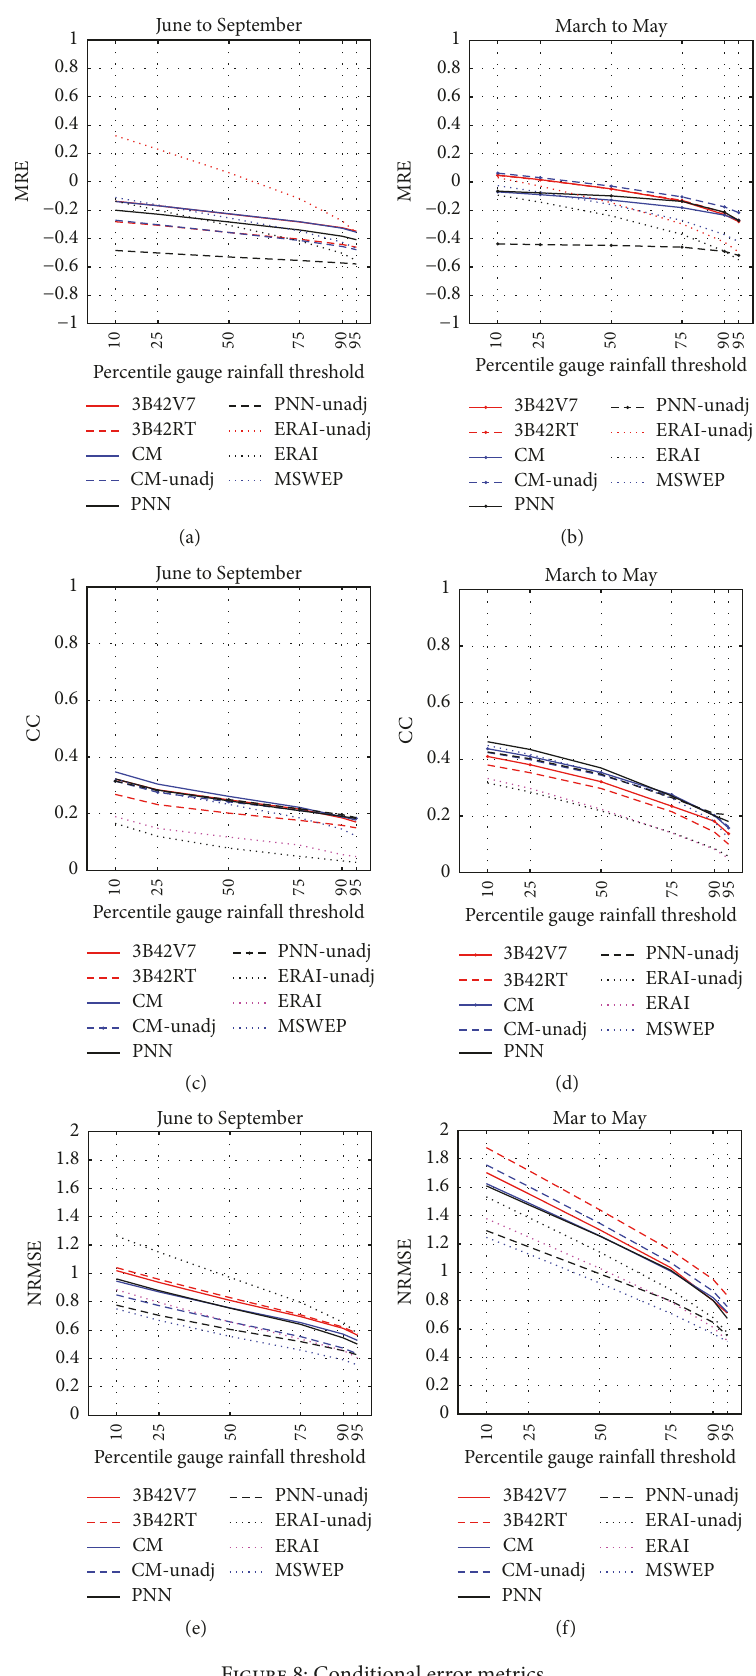
Figure 8: Conditional error